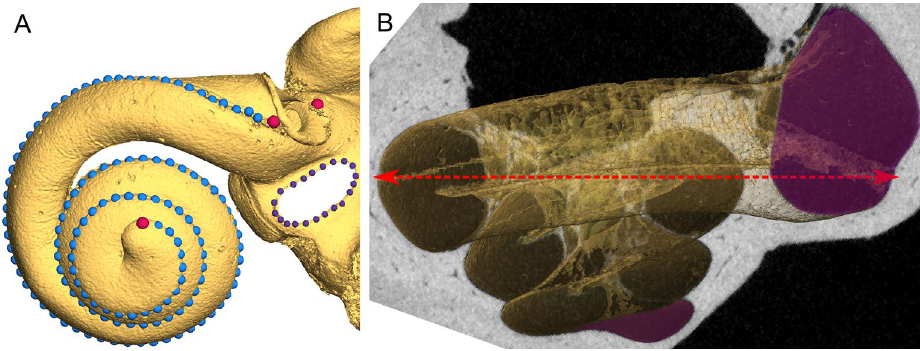
Figure 1. Landmark placement along the cochlea and oval window, and cross-section of the cochlea showing how cochlea width was obtained. ( A ) 3D reconstruction of inner ear based on a µCT scan, with landmarks placed alongside the outermost curvature of the cochlea in blue and around the oval window in purple. Red landmarks on the cochlea were placed manually, while blue landmarks were originally placed manually but later automatically resampled to reach 127. Landmarks around the oval window were not used to measure shape, but only to calculate its area. ( B ) Cross-section of the cochlea, with a red arrow indicating how cochlea width was measured for the first turn. Shaded sections indicate the positions at which the cross-section area of the first and last turns where